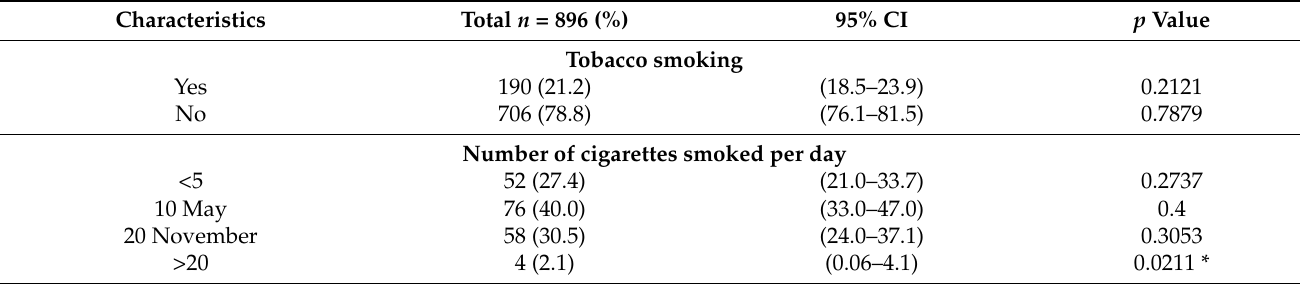
Table 2. Tobacco smoking prevalence among primary care